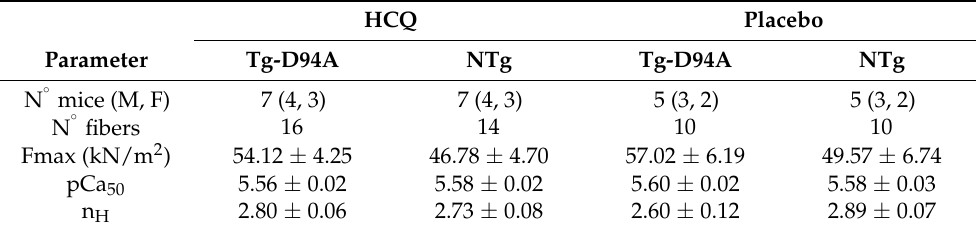
Data are the mean ± SEM of N o = 5–7 mice (10–16 fibers) per group. No statistical significance was found by two-way ANOVA followed by Sidak’s multiple comparison test. Abbreviations: Male (M), female (F) mice, Fmax, maximal pCa4 force, pCa 50 , calcium sensitivity, n H , Hill